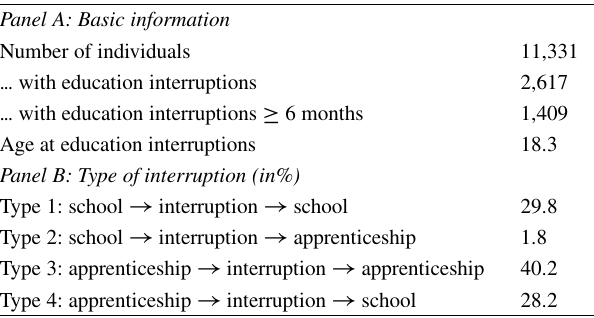
Fig. 2 Socio-economic status during the educational interruption. ( Source: BASiD 2007. Notes: The figure shows the socio-economic status during the educational interruption. Sub-figure a pools all available observations. Sub-figure b conditions on short interruptions defined as those less than six months. Sub-figure c conditions on long interruptions defined as those lasting at least six months or more. See Fig. 3 for a differentiation by type of interruption) Table 1 Description of the BASiD